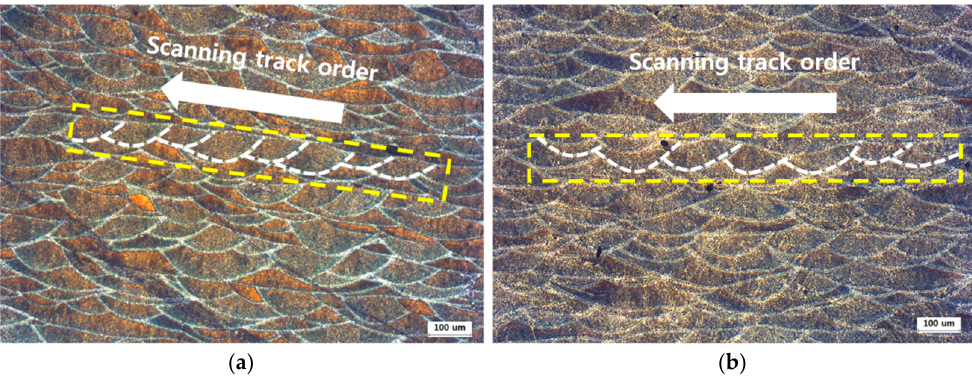
Figure 12. Shape of overlapped tracks with hatch spacing of ( a ) 0.1 mm and ( b ) 0.14